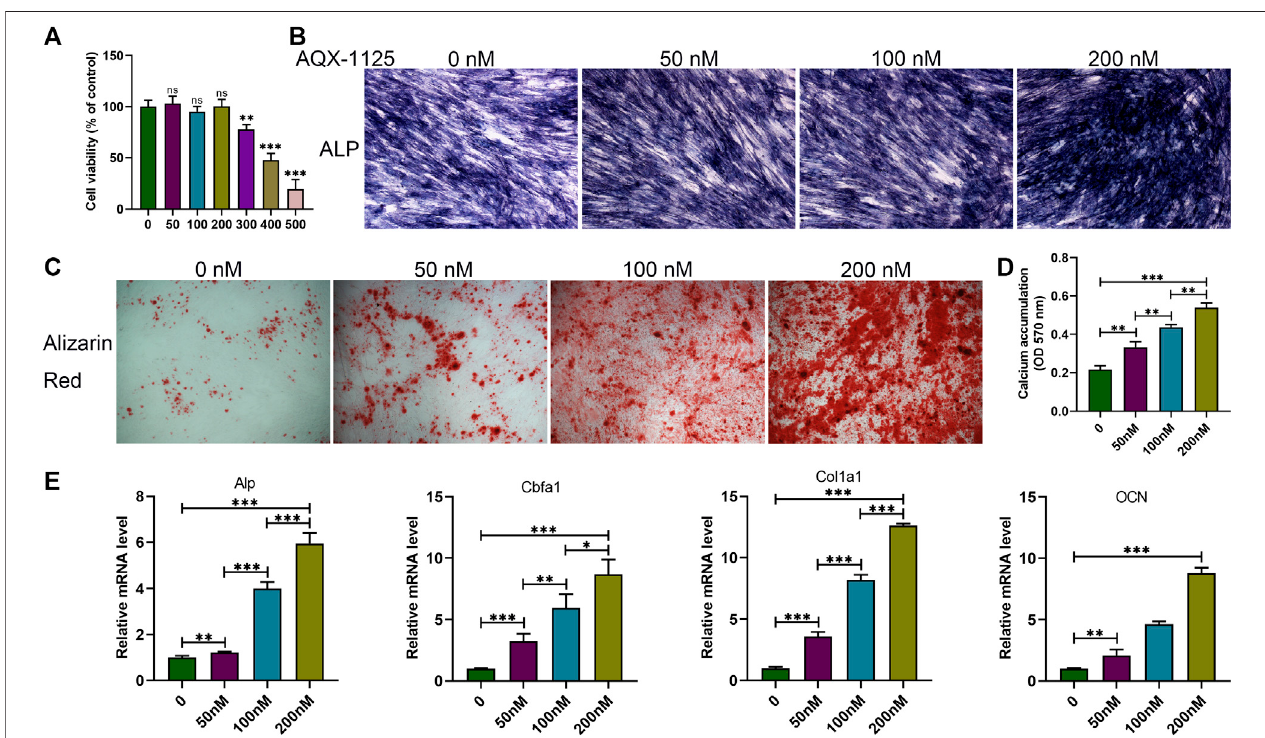
FIGURE 2 | AQX-1125 facilitates osteoblast differentiation. (A) Effect of AQX-1125 on BMSCs viability. (B,C) BMSCs were cultured in osteogenic differentiation medium with various concentrations of AQX-1125, as indicated for 14 days (B, Alp staining) or 21 days (C, alizarin red staining. scale bars = 100 μ m). (D) Matrix mineralization was assessed by quantitative analysis of alizarin red S staining in (C) . (E) Relative mRNA expression level of Alp, Cbfa1, Col1a1, and OCN in BMSCs treated with AQX-1125, as indicated for 24 h. Data are presented as means ± SD from three independent experiments (* p < 0.05; ** p < 0.01; and *** p < 0.001).